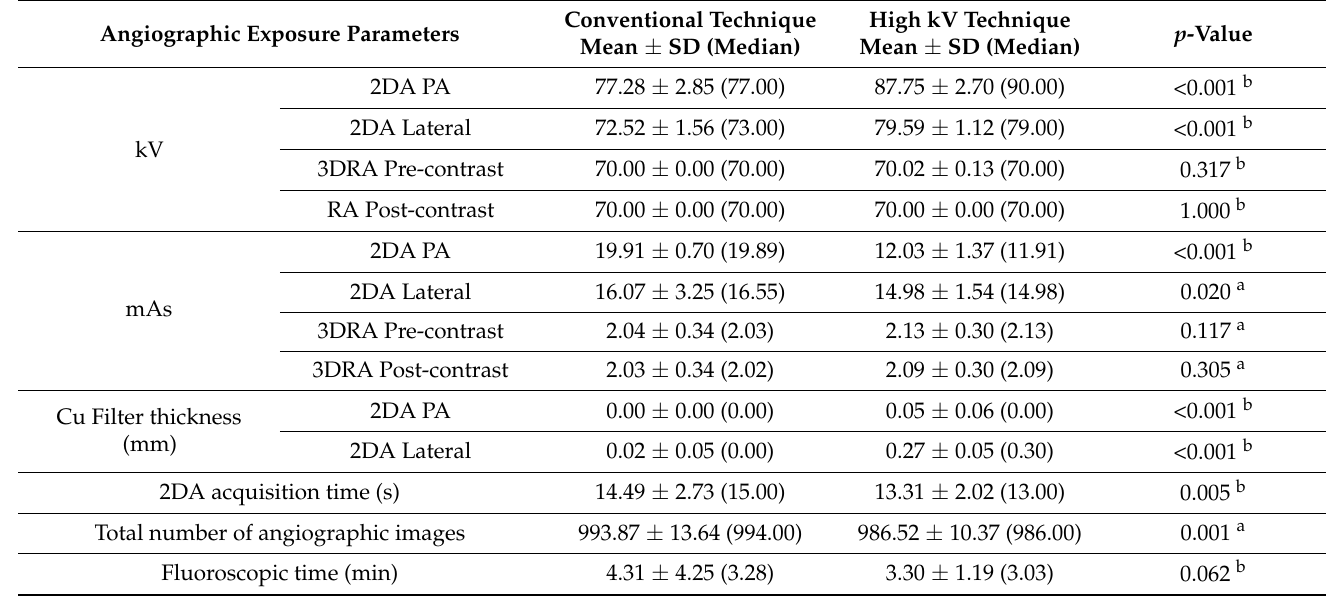
Table 2. The cerebral angiographic exposure parameters from the conventional and high kV techniques. Conventional Technique High kV Technique Angiographic Exposure Parameters Mean ± SD (Median) Mean ± SD